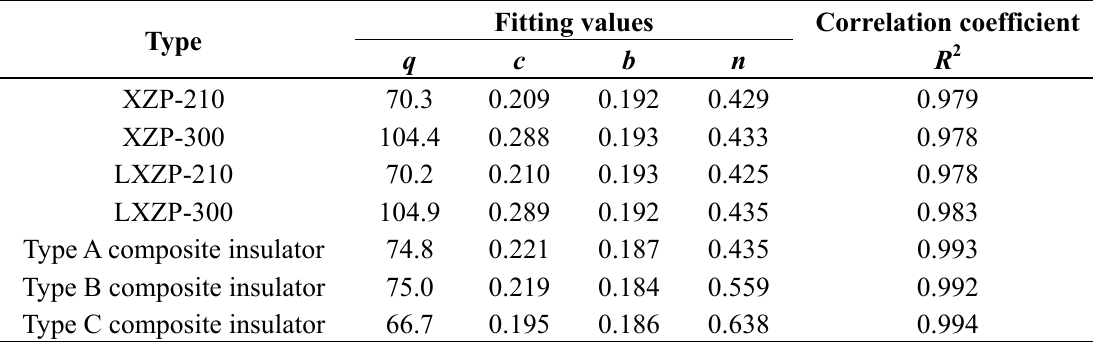
Table 9. Fitting values of q , c , b , n , and R 2 according to the test results of typical insulators with Equation